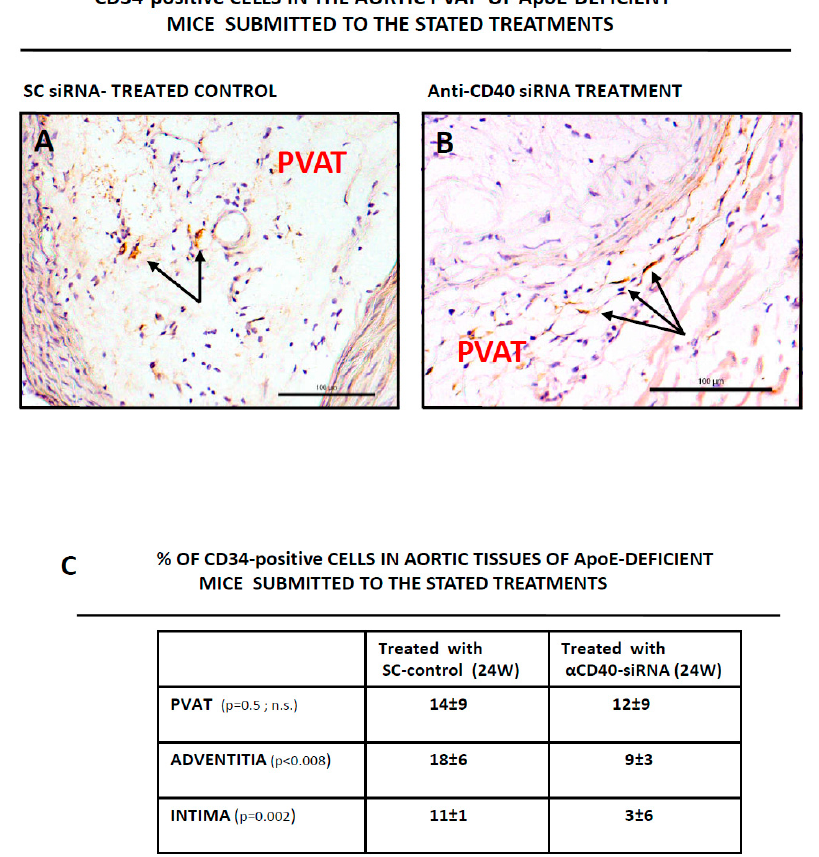
Figure 3. Detection of CD34-positive cells in the murine aortic perivascular tissue. Aortas from